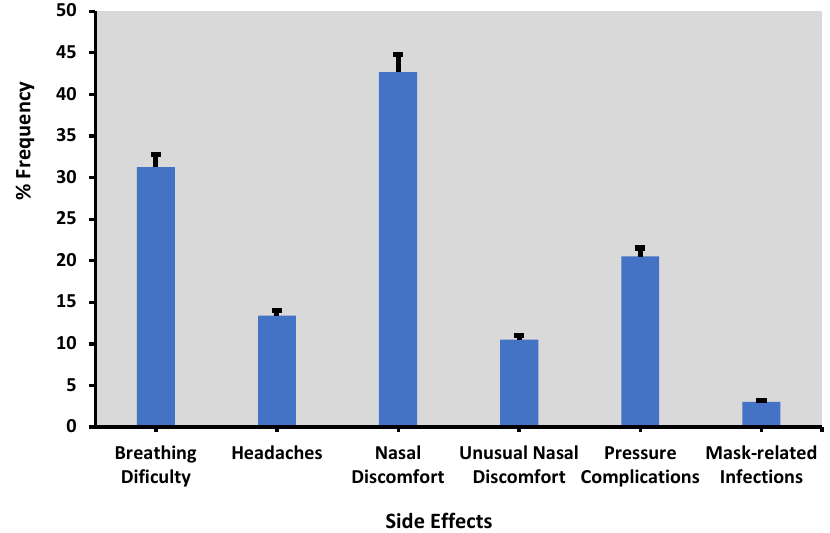
Figure 2. Side effects of nose mask usage as indicated by the respondents. Error bars represent the percentage of reported side effects.